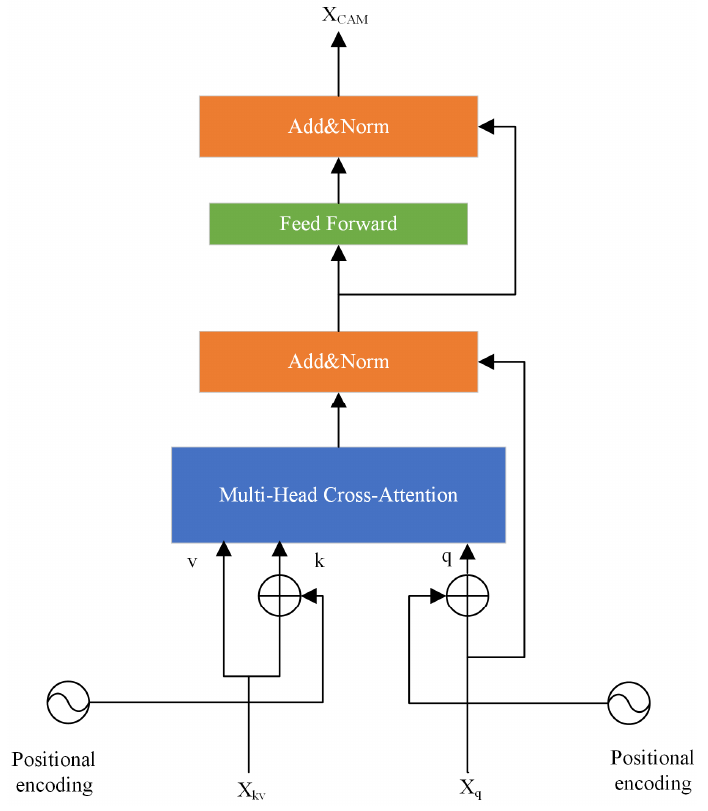
Figure 5. Cross A tt ention Module (CAM). Figure 5. Cross Attention Module